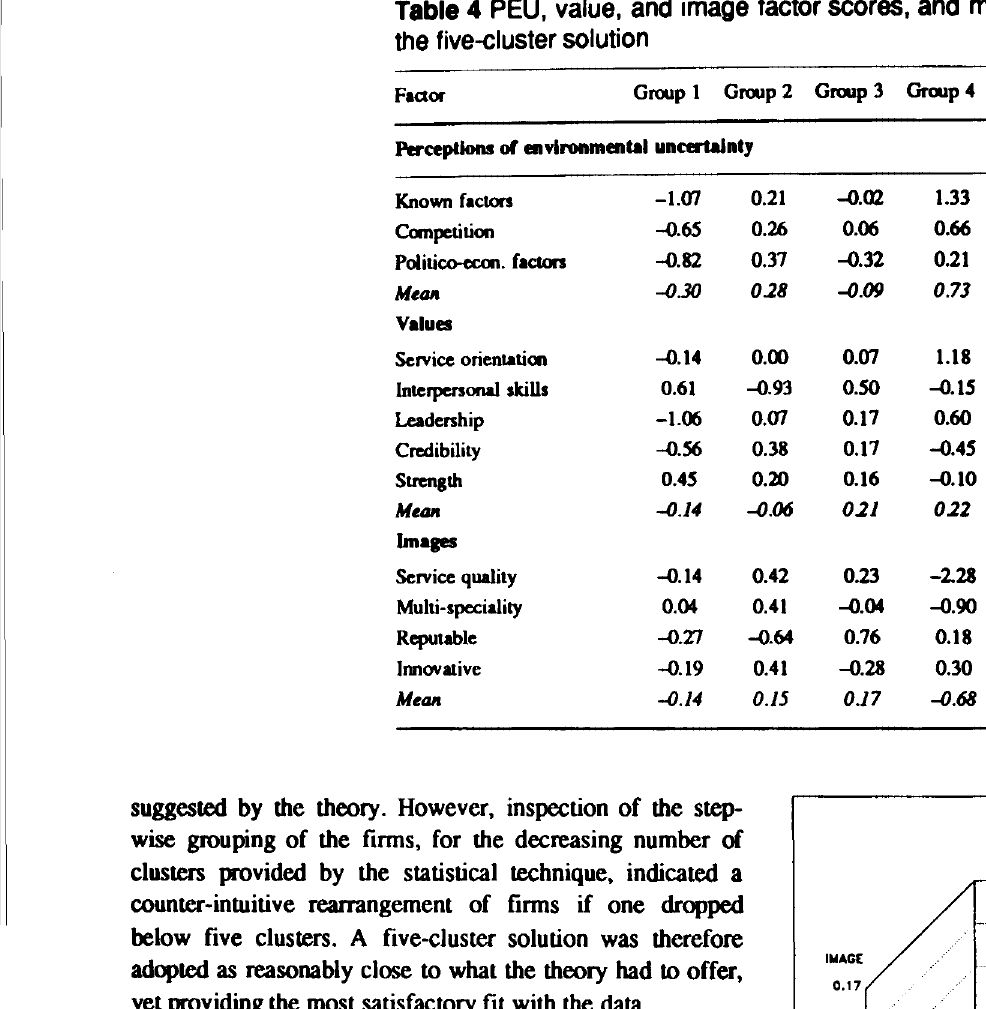
Table 4 PEU, value, and image factor scores, and means, for